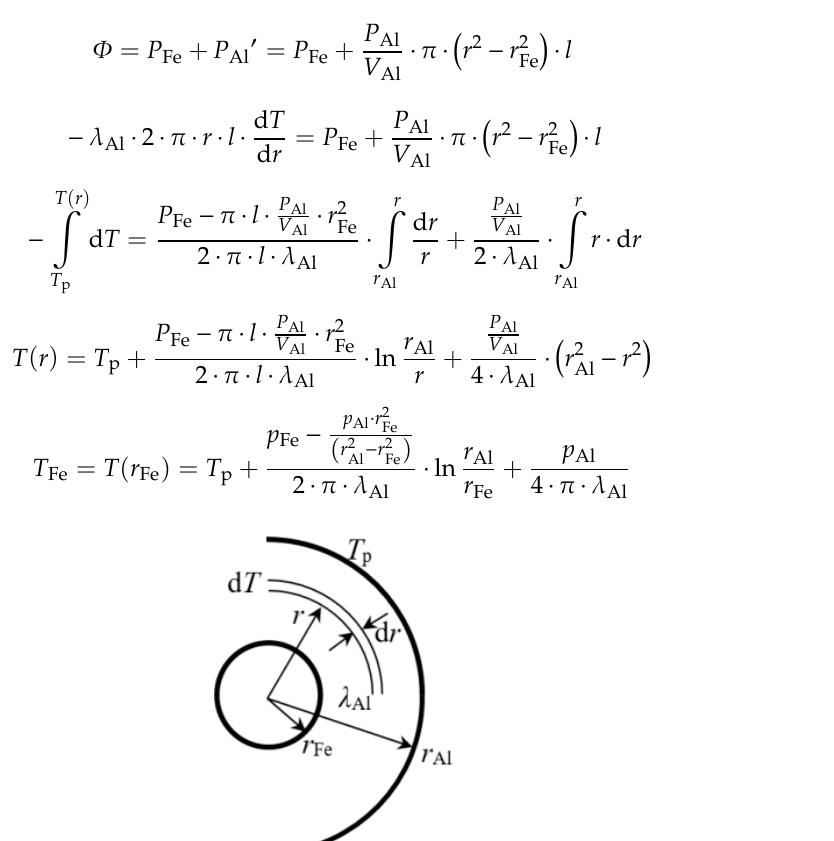
Figure 5. The heat balance of the conductor in the sun, taking into account electrical heating and convection. Note: sun = 30 W, surrounding = 40 W, Joule´s heating = 70 W, convection = 55 W, conductor at 43 °C = 54 W.